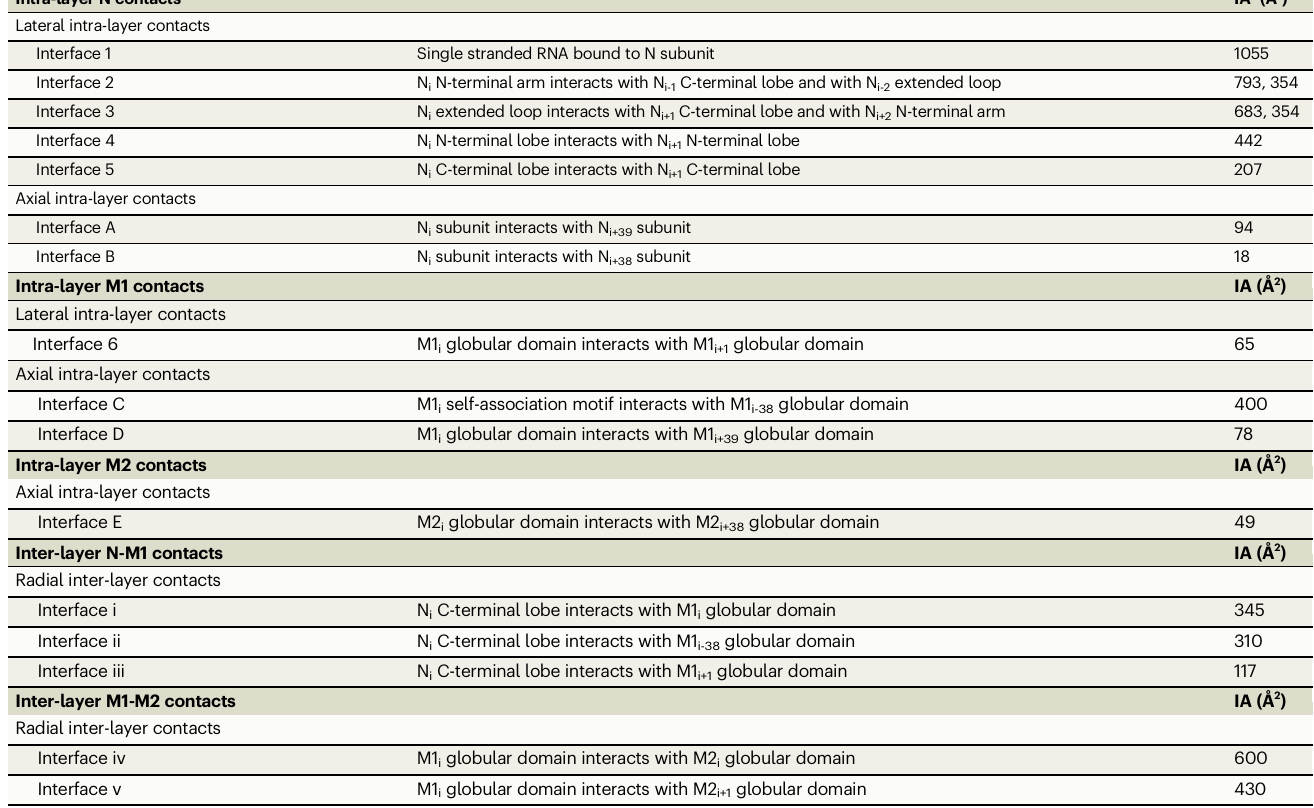
Table 1 | Subunit interactions in the VSV